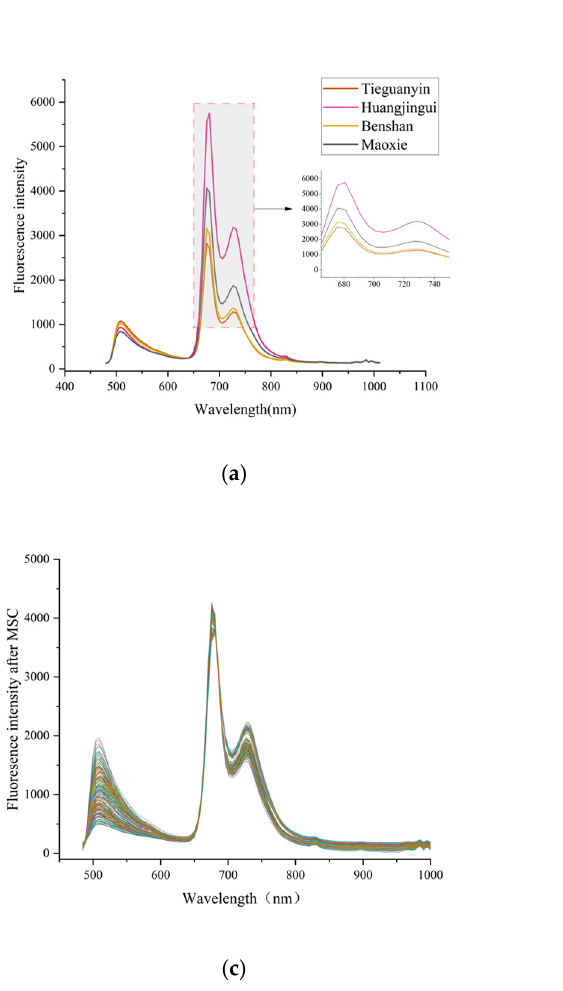
Figure 1. ( a ) Average spectra of four oolong teas; ( b ) three-dimensional plot of the spectral curves; ( c ) spectra after MSC; ( d ) spectra after SNV. ( c ) spectra after MSC; ( d ) spectra after